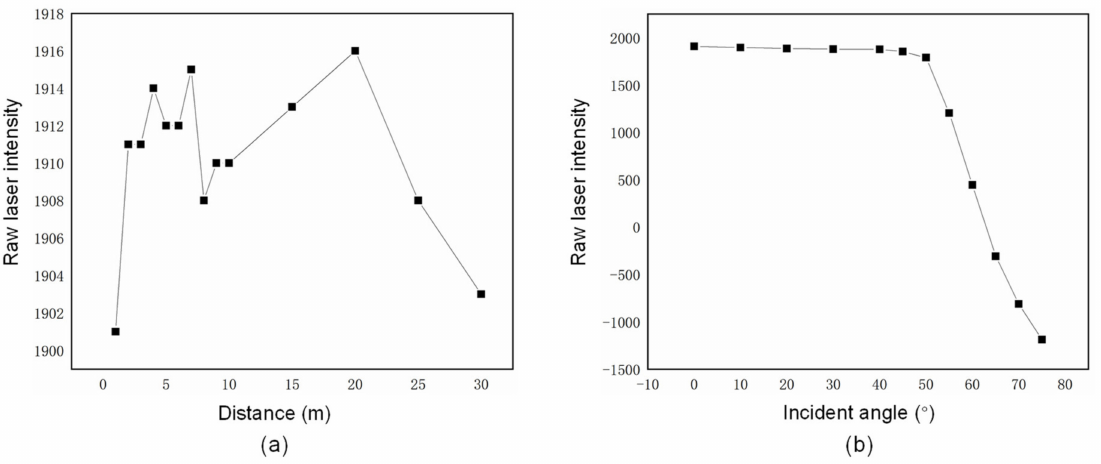
Figure 4. The relationship between raw laser intensity and distance or incidence angle. ( a ) The relationship between laser intensity and distance; ( b ) The relationship between laser intensity and incidence